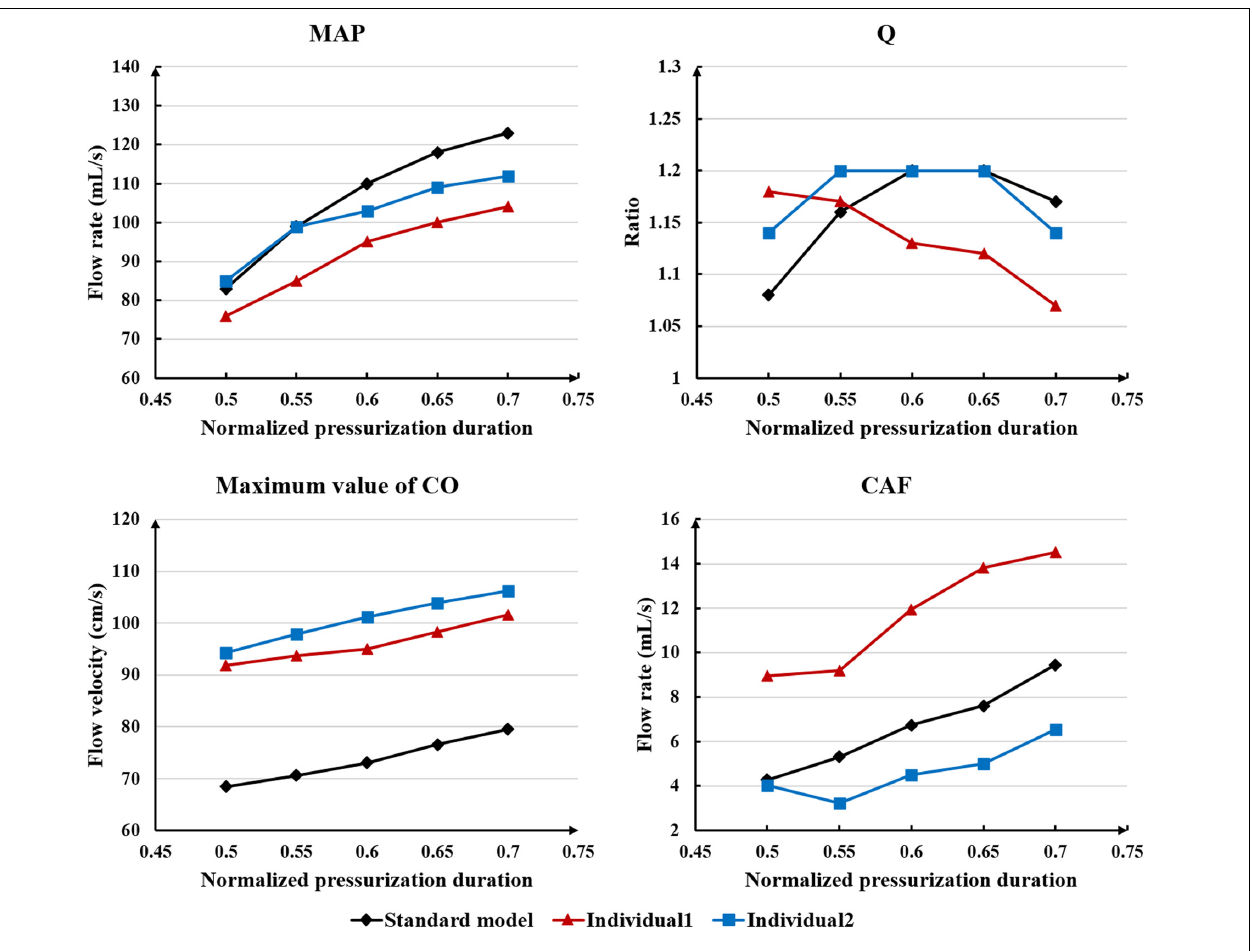
FIGURE 7 | The variations of acute hemodynamic effects under different pressurization durations. TABLE 2 | Compared with the resting state, the variations of MAP, Q, max CO velocity, and CAF of the three models when the pressure was released at 0.7 s, where IP is increased